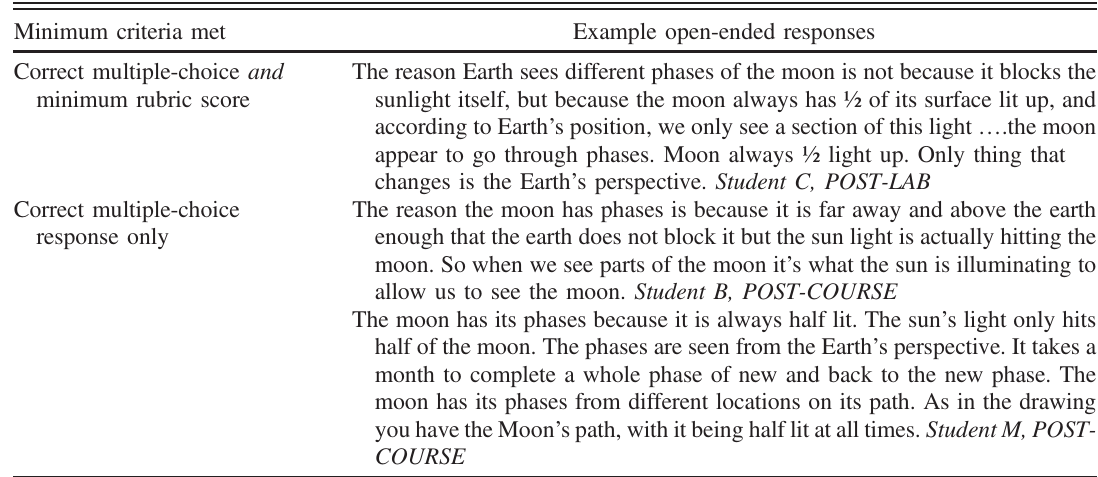
TABLE VIII. Example open-ended responses given for the assessment regarding the cause of the Moon ’ s phases. Minimum criteria